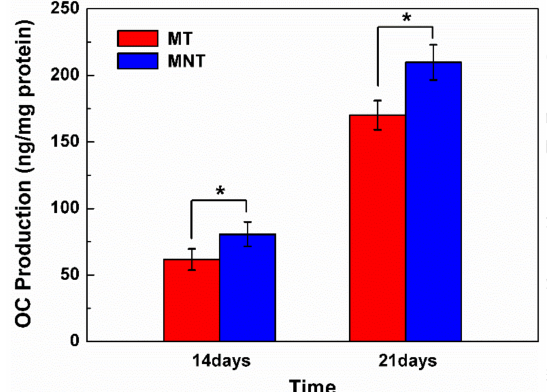
Figure 13. Comparative quantification of osteocalcin secretion on different surfaces of MT and MNT coatings after 14 and 21 days. (* represents p <